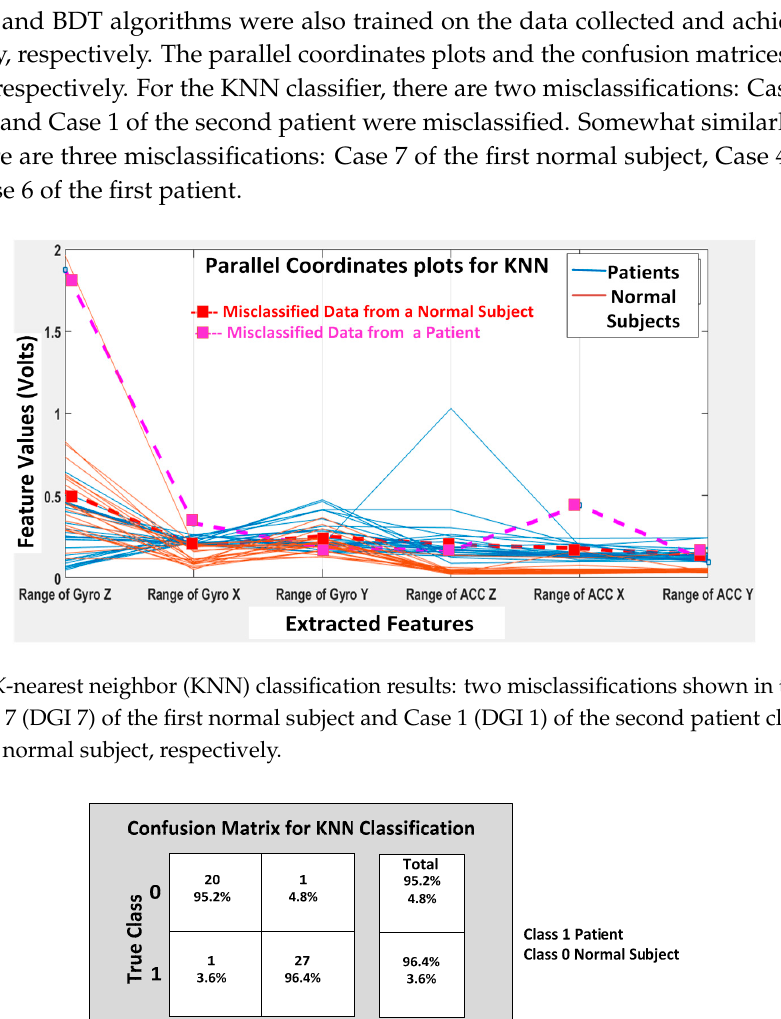
classification model with the true positive rate (TPR) and false positive rate (FPR). model with the true positive rate (TPR) and false positive rate (FPR).